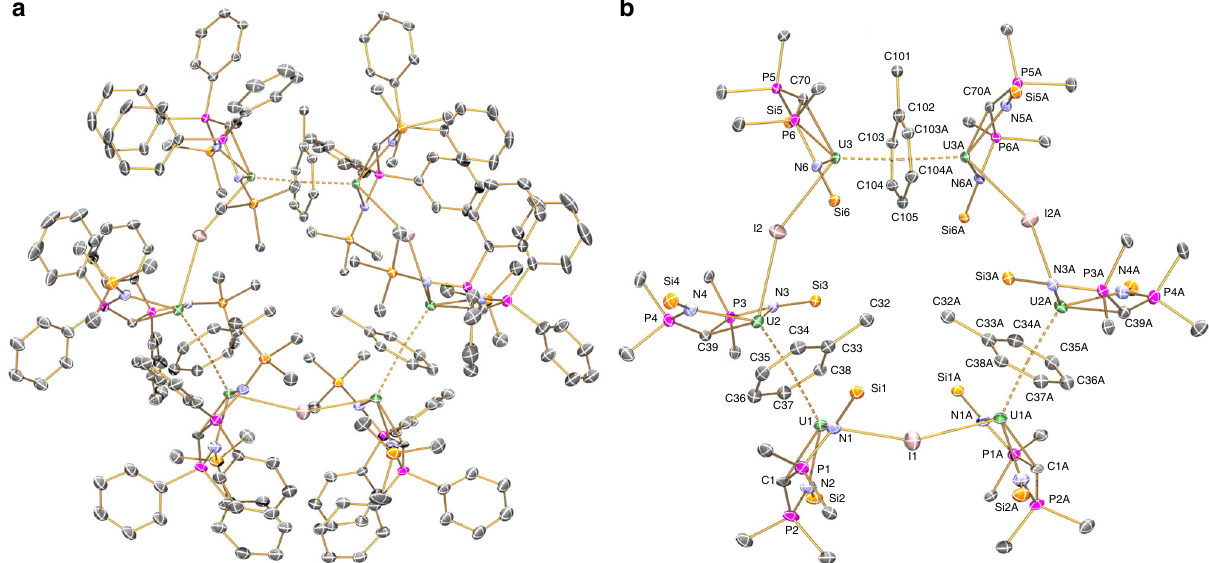
Fig. 2 Molecular structure of 3 at 90 K and displacement ellipsoids set to 40%. a Full structure with hydrogen atoms, lattice solvent, and the disordered Ph 2 PCPPh 2 portion of the BIPM TMS coordinated to U1/U1A are omitted for clarity. b Structure highlighting the U 6 ( μ - η 6 : η 6 -C 6 H 5 Me) 3 ( μ -I) 3 core with hydrogen atoms, lattice solvent, silyl-methyls, disordered P -phenyls bar the ipso -carbon, and the disordered Ph 2 PCPPh 2 portion of the BIPM TMS coordinated to U1/U1A are omitted for clarity. Each toluene methyl group is disordered such that they are directed towards the centre of the ring or in the opposite direction outwards and the combinations shown are arbitrary. Key: uranium, green; phosphorus, magenta; silicon, orange; iodide, pink; nitrogen, blue; carbon, grey